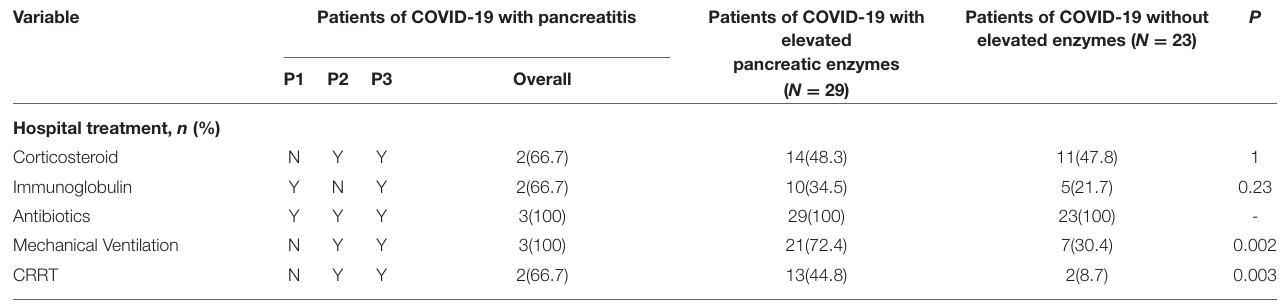
TABLE 4 | Treatments of patients with COVID-19. Variable Patients of COVID-19 with pancreatitis Patients of COVID-19 with